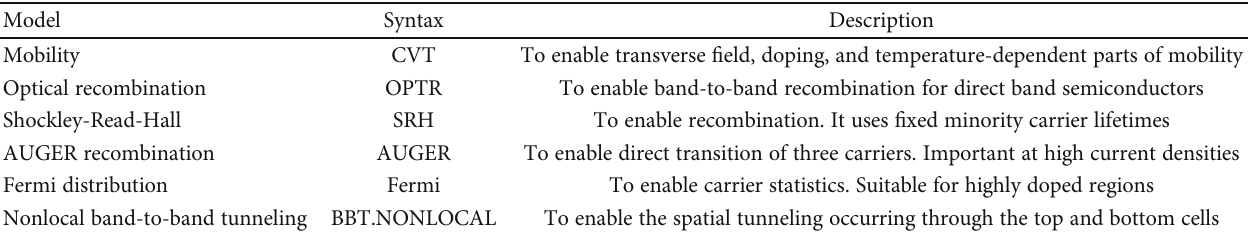
Table 1: Basic physical models used in SILVACO ATLAS simulation.